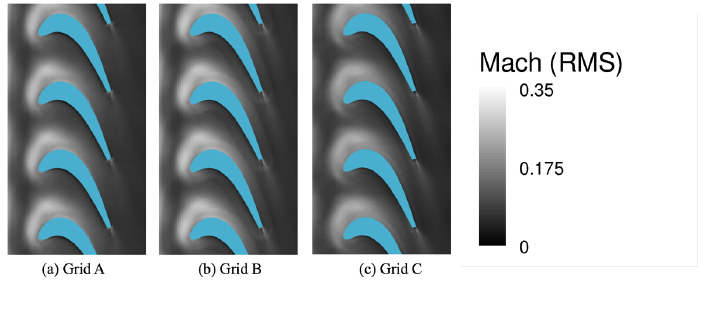
Figure 12. Mean Mach number contours near the stator–rotor region at the location of 50% span of the rotor blade for: ( a ) Grid A; ( b ) Grid B; and ( c ) grid C.